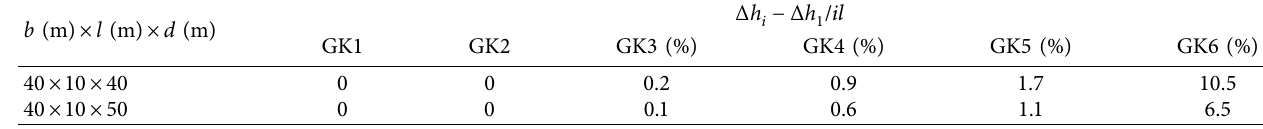
Table 2: Comparison of water level increment ratios caused by a hydraulic conductivity ratio